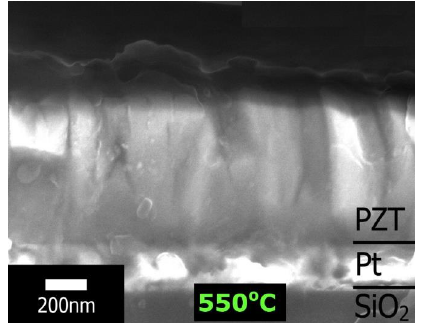
Figure 5. Cross-section of film deposited at 550 °C substrate